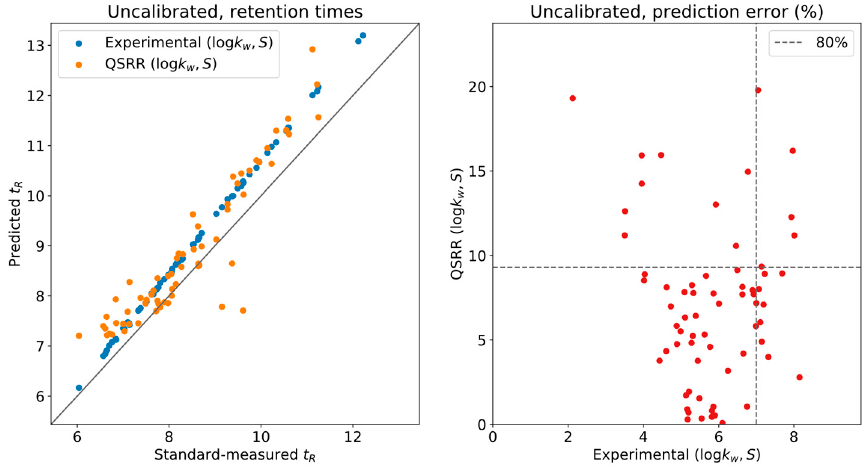
Figure 1. Uncalibrated retention times.